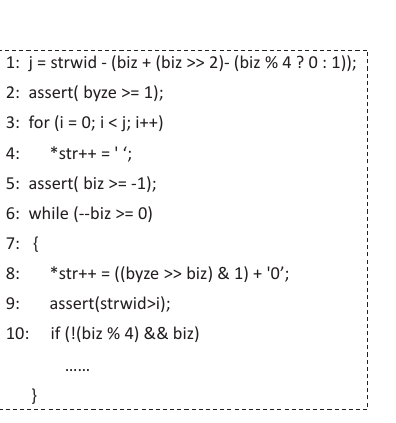
Figure 8. An example of a program segment.